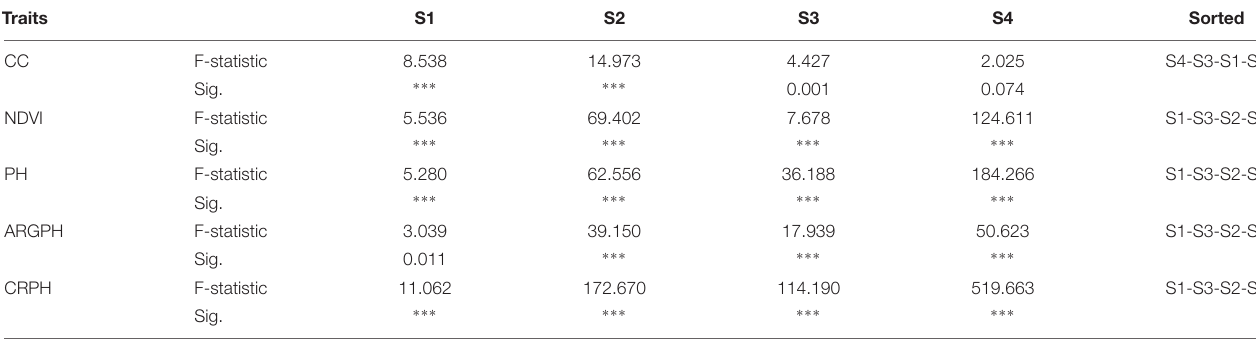
TABLE 3 | Trait difference between different growth stages. Traits